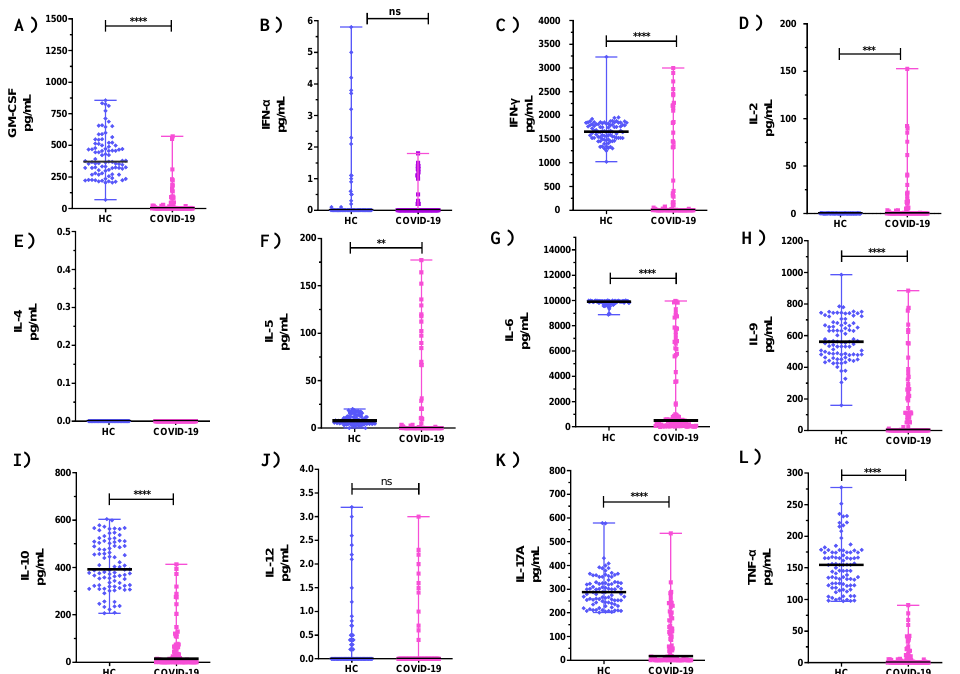
Figure 1. Cytokine profiles of PHA-stimulated PBMCs from healthy subjects and COVID-19 ICU patients ( A – L ). ** p < 0.01, *** p < 0.001, **** p < 0.0001 refers to the statistical differences. HC: healthy controls; ns: not significant. Cytokine levels of PHA-stimulated neutrophils from COVID-19 ICU patients and HC are shown in Figure 2. Statistically significant lower levels were detected for GM-CSF, IFN- α, IFN - γ, IL -2, IL-4, IL-5, IL-6, IL-9, IL-10, IL-17A, and TNF- α ( Figure 2A, 2C – L; p < 0.0001 Figure 2B, p < 0.01).